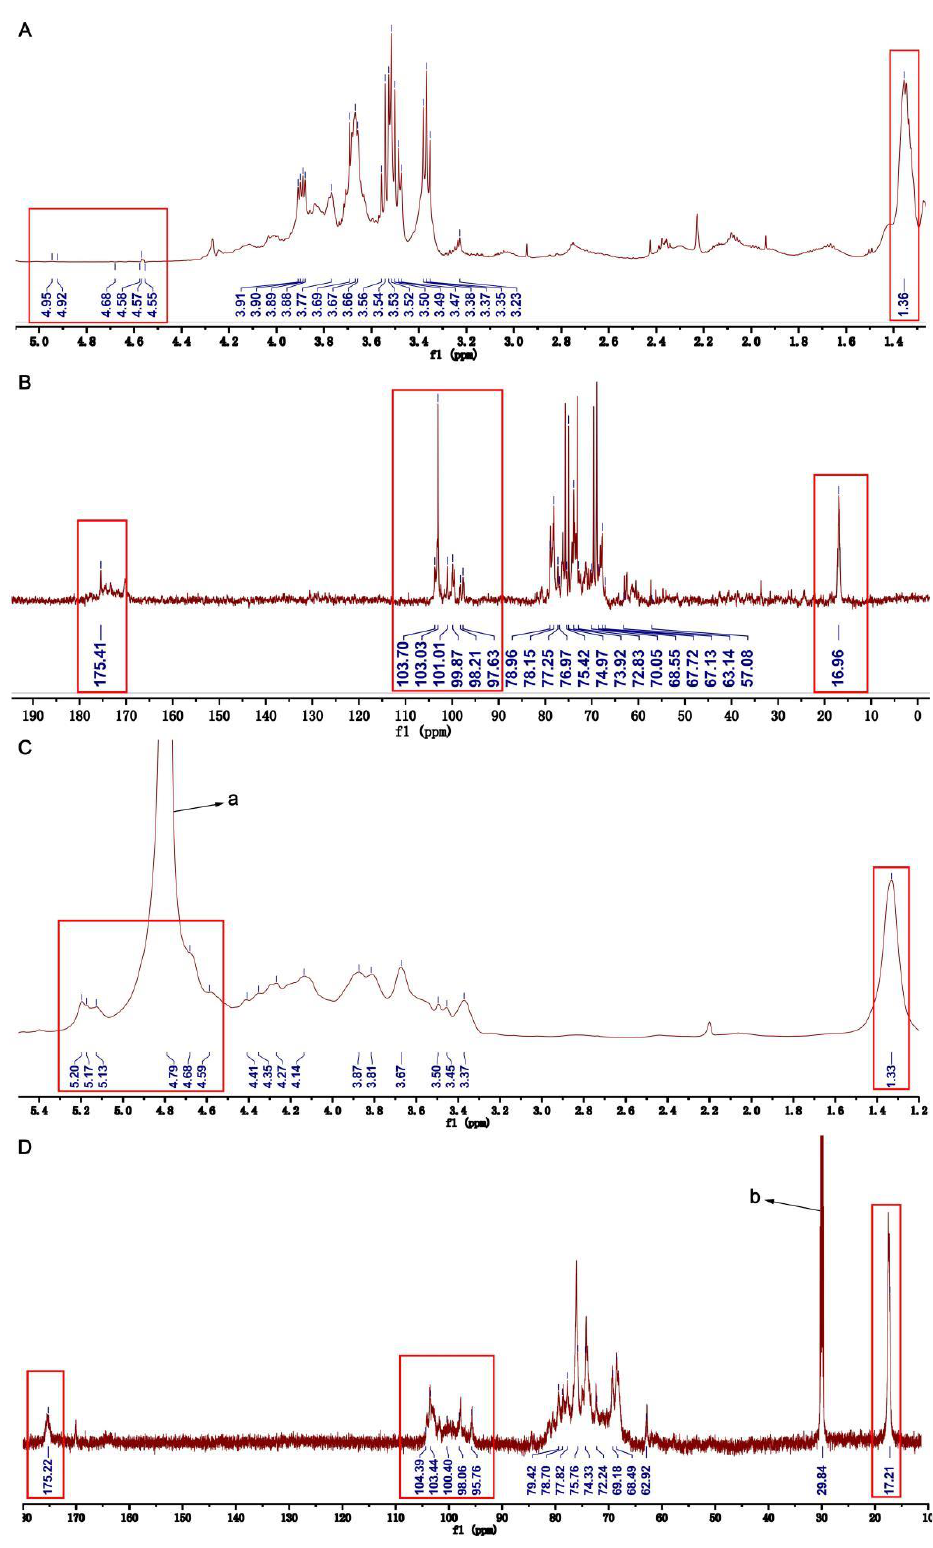
Figure 2. One-dimensional NMR of U and HU. ( A ) 1 H NMR of U. ( B ) 13 C NMR of U. ( C ) 1 H NMR of HU. ( D ) 13 C NMR of HU. ( a ) The peak of HOD. ( b ) The peak of acetone-d6 (defining peak).